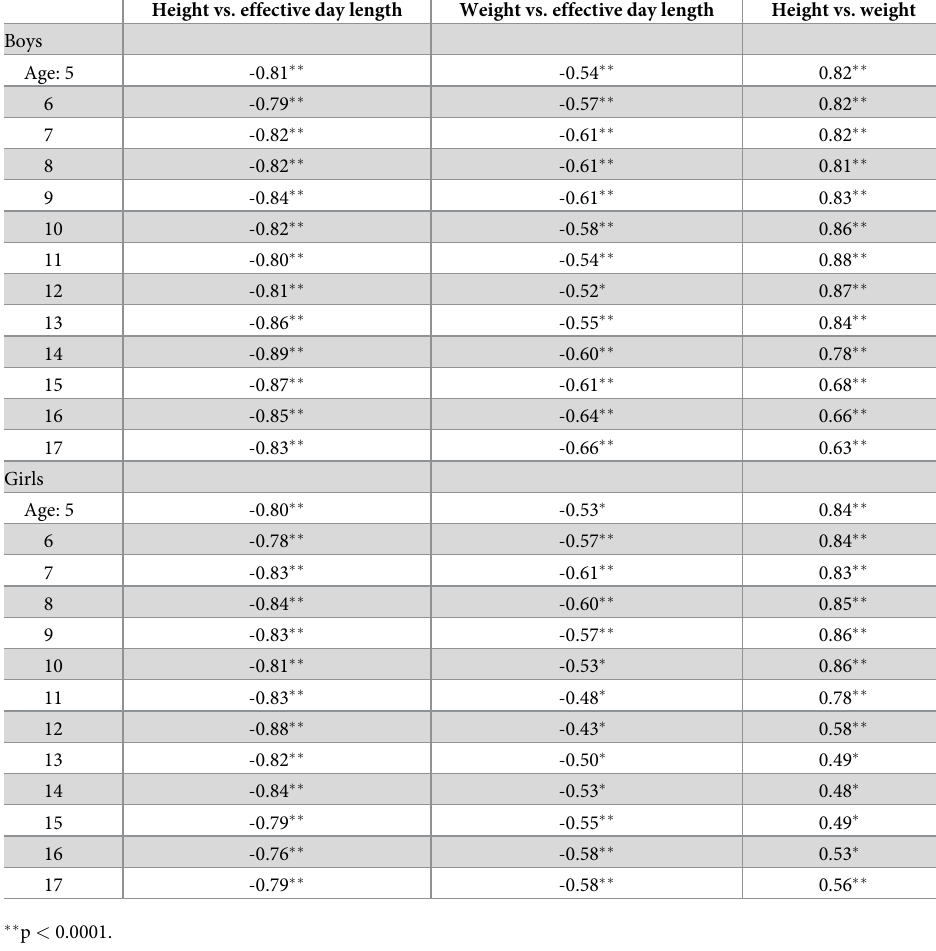
Table 3. Pearson’s correlation coefficients for the relationship between height, weight, and effective day length. Height vs. effective day length Height vs.